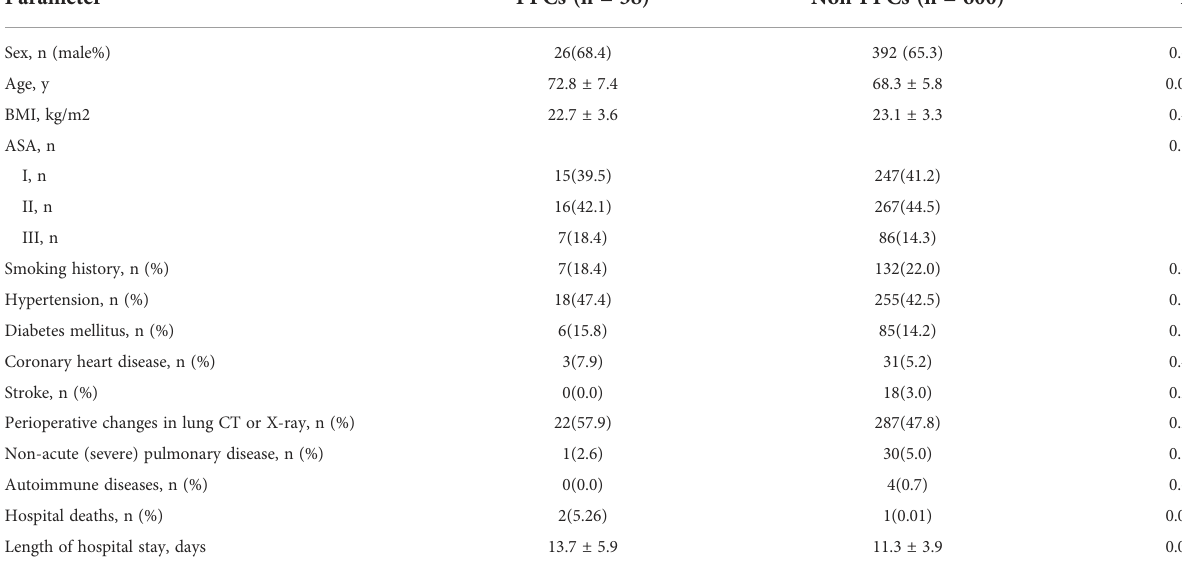
TABLE 1 General characteristics and postoperative outcomes of patients.